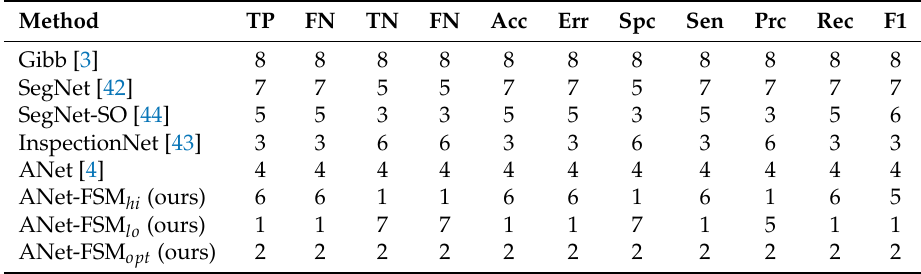
Table 5. Ranking of each method based on individual quantitative